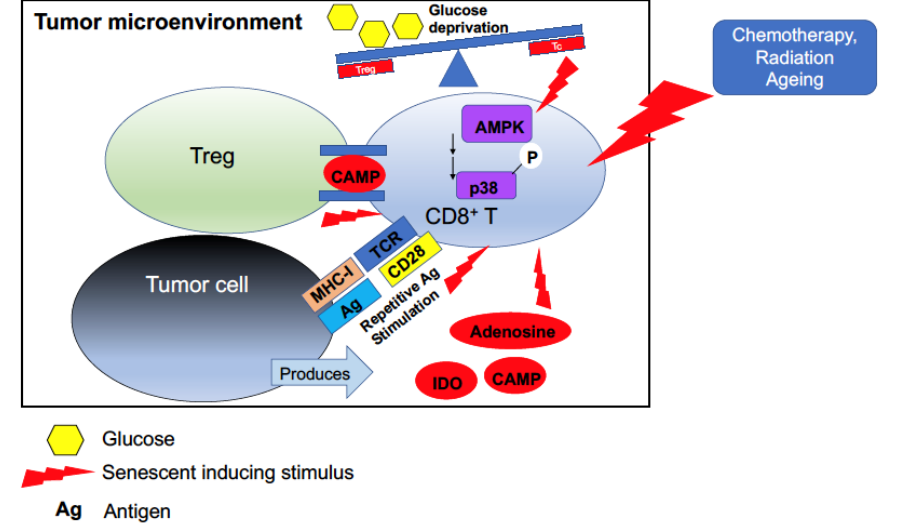
Figure 2. T cell senescence can occur via multiple mechanisms within the tumor microenvironment. Tregs, through glucose metabolic competition and transfer of cAMP produced by tumors, can induce CD8 + T cell senescence, as can other metabolites produced by tumor cells, such as adenosine. Repeated antigen stimulation and external factors such as chemotherapeutic and radiation therapy also induce premature senescence. A key molecular pathway involved in CD8 + T cell senescence induction is non-canonical signaling through p38-MAPK.